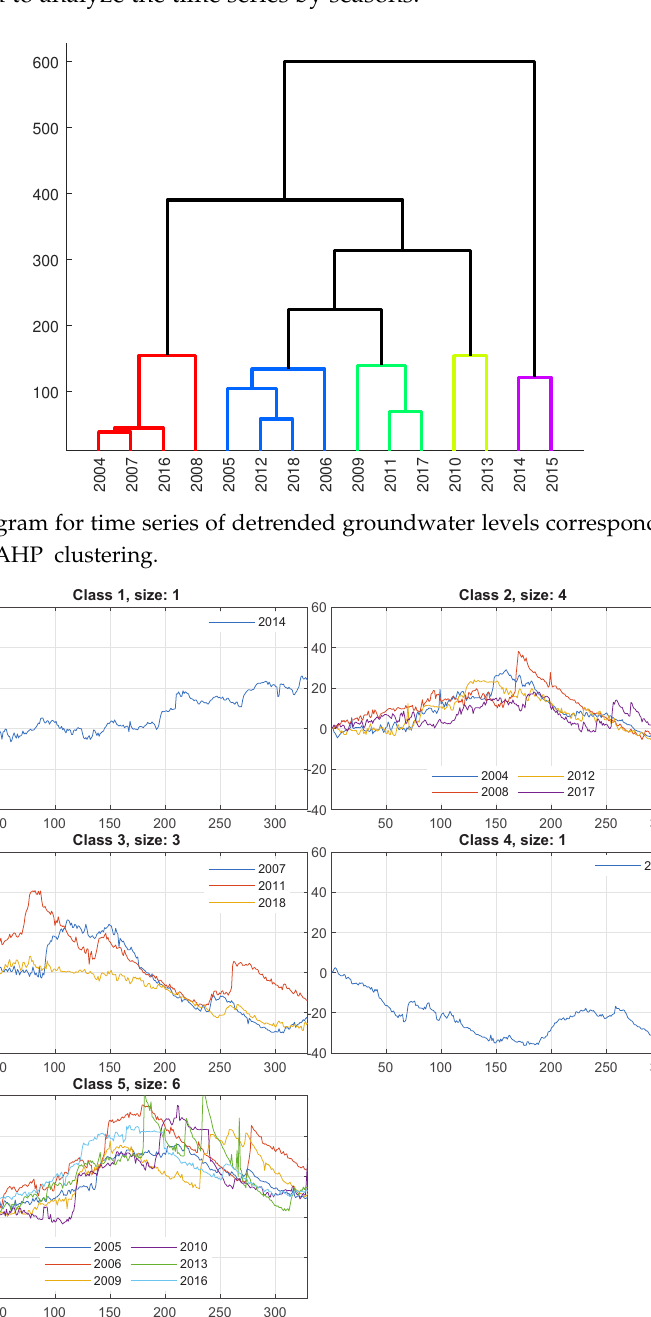
Figure 12. Clustering of the time series of detrended groundwater levels corresponding to the HYs by applying the AHP method. The years presented in the legend correspond to the years in the dendrogram (Figure